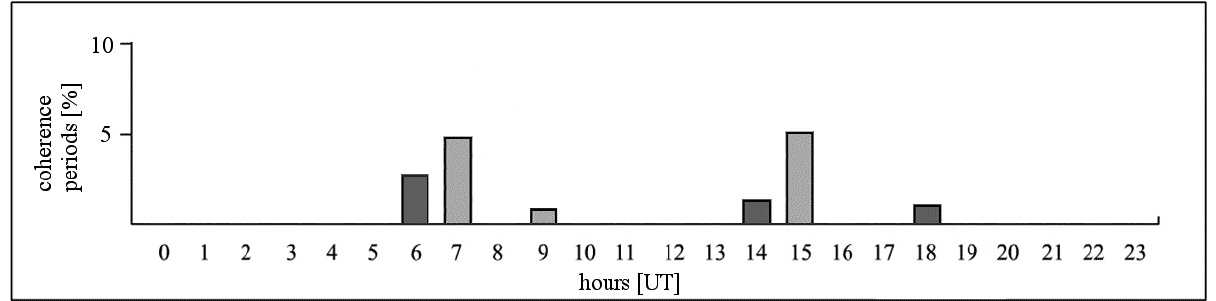
= 1 dBm and T = 5 km. dBm h'